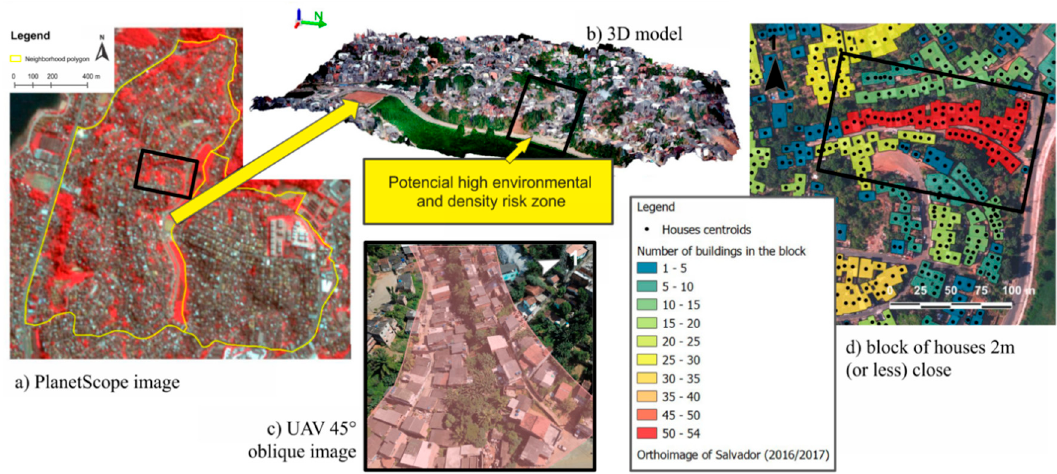
Figure 9. ( a ) Boundaries of the two selected settlements in Salvador (Brazil) showing a PlanetScope image of 3 m resolution; ( b ) 3D point cloud-based model; ( c ) UAV 45 ◦ oblique image of a high-risk area due to high built-up density located in a sink; ( d ) blocks of houses based on their proximity to each other.